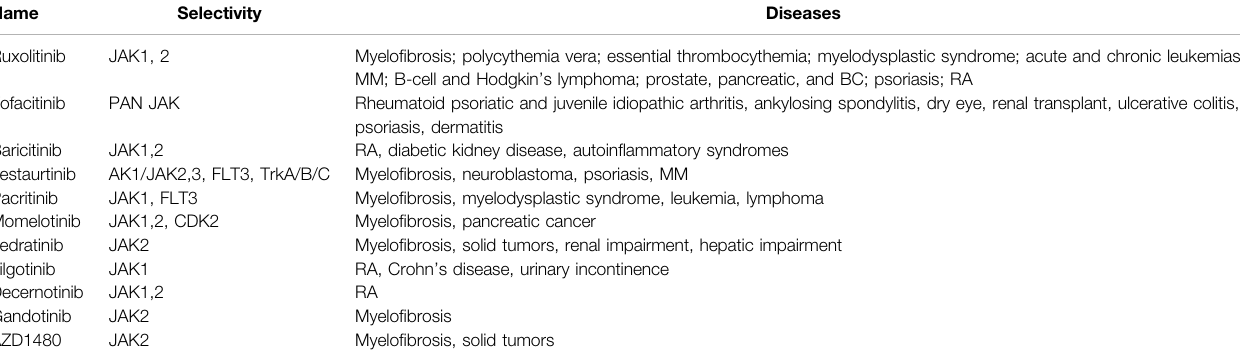
TABLE 1 | Most common JAKis: their preferential targets and diseases where they are on market/in clinical